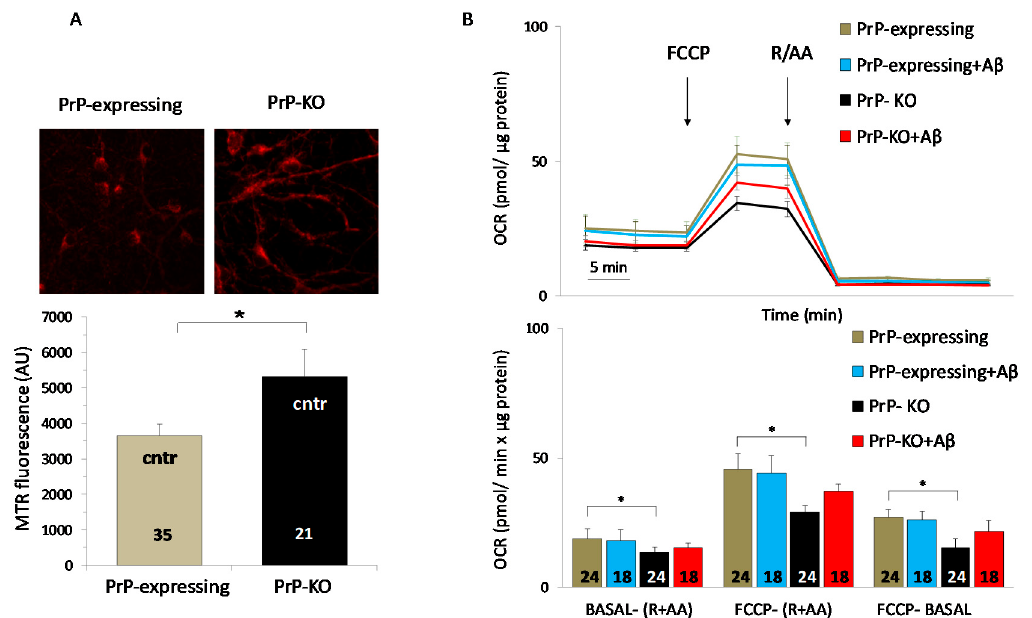
Figure 3. PrP C controls mitochondrial oxygen consumption rate so as to reduce ROS production. ( A ) Higher quantities of reactive oxygen species (ROS) are present in mitochondria of control PrP-KO cortical neurons compared to the PrP-expressing counterparts. This is evident from both the upper panel, showing representative fluorescence micrographs of neurons loaded (30 min, 37 °C) with the ROS-sensitive mitochondrial matrix-accumulating cationic probe MitoTracker Red (MTR, 50 nM ( λ exc = 579 nm, λ em = 599 nm), Molecular Probes), and the lower bar diagram reporting the corresponding MTR fluorescence quantification. Coverslip images were collected using an inverted microscope (Olympus IMT-2) equipped with a Xenon lamp, a 40× oil-immersion objective, appropriate excitation and emission filters and a cooled 16-bit digital CCD camera (Micromax, Princeton Instruments). Following the selection of mitochondria-rich fields in each coverslip, their mean MTR fluorescence was calculated after subtracting the background fluorescence collected in dark fields. ( B ) Compared to PrP-expressing neurons (grey), PrP-KO neurons (black) have a reduced oxygen consumption rate (OCR), as both OCR representative traces (upper panel), and their quantification (lower panel), indicate. Quantification of basal (BASAL-(R + AA)) and maximal (FCCP-(R + AA)) OCR values were calculated by subtracting non-mitochondrial OCR value, obtained after adding mitochondrial respiration blockers antimycin A (AA) and rotenone (R), from the OCR measured, respectively, before and after addition of the respiration uncoupler carbonyl cyanide 4-(trifluoromethoxy)phenylhydrazone (FCCP). Mitochondrial spare respiratory capacity (FCCP-BASAL) was calculated by subtracting the basal OCR value from the maximal OCR value. These results suggest that the slower electron flow by mitochondria of PrP-KO neurons renders more reduced the redox centers of the respiratory chain complexes of these cells, favoring the supply of electrons to oxygen and the production of superoxide anion radicals. However, A β -addition does not significantly alter the OCR in either PrP-expressing (light blue) and PrP-KO (red) neurons. For these measurements, neurons were isolated and plated onto XF24 microplate wells (Agilent) for seven days, at the end of which they were treated, or not, with A β 1-42 oligomers. OCR values were real-time assessed with the XF24 Extracellular Flux Analyzer (Agilent), which allows to measure OCR changes after the sequential addition of FCCP (0.5 µM), and antimycin A (1 µM) plus rotenone (1 µM) together. Results were normalized to the protein content determined by a commercial kit (Total Protein Kit, micro Lowry, Peterson ′ s modification, Sigma). * p < 0.05 (Student ′ s t -test). Other details are as in the legend to Figures 1 and 2.